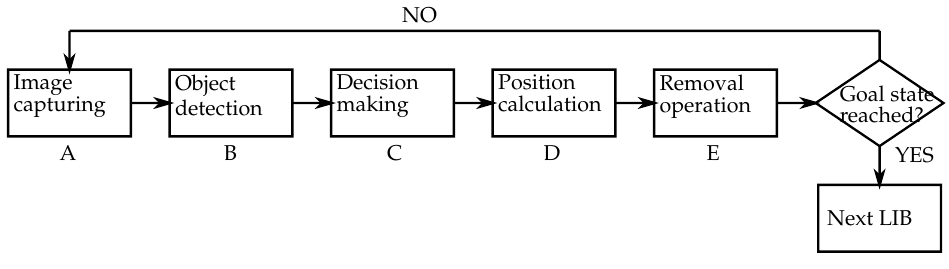
Figure 1. Task planner concept